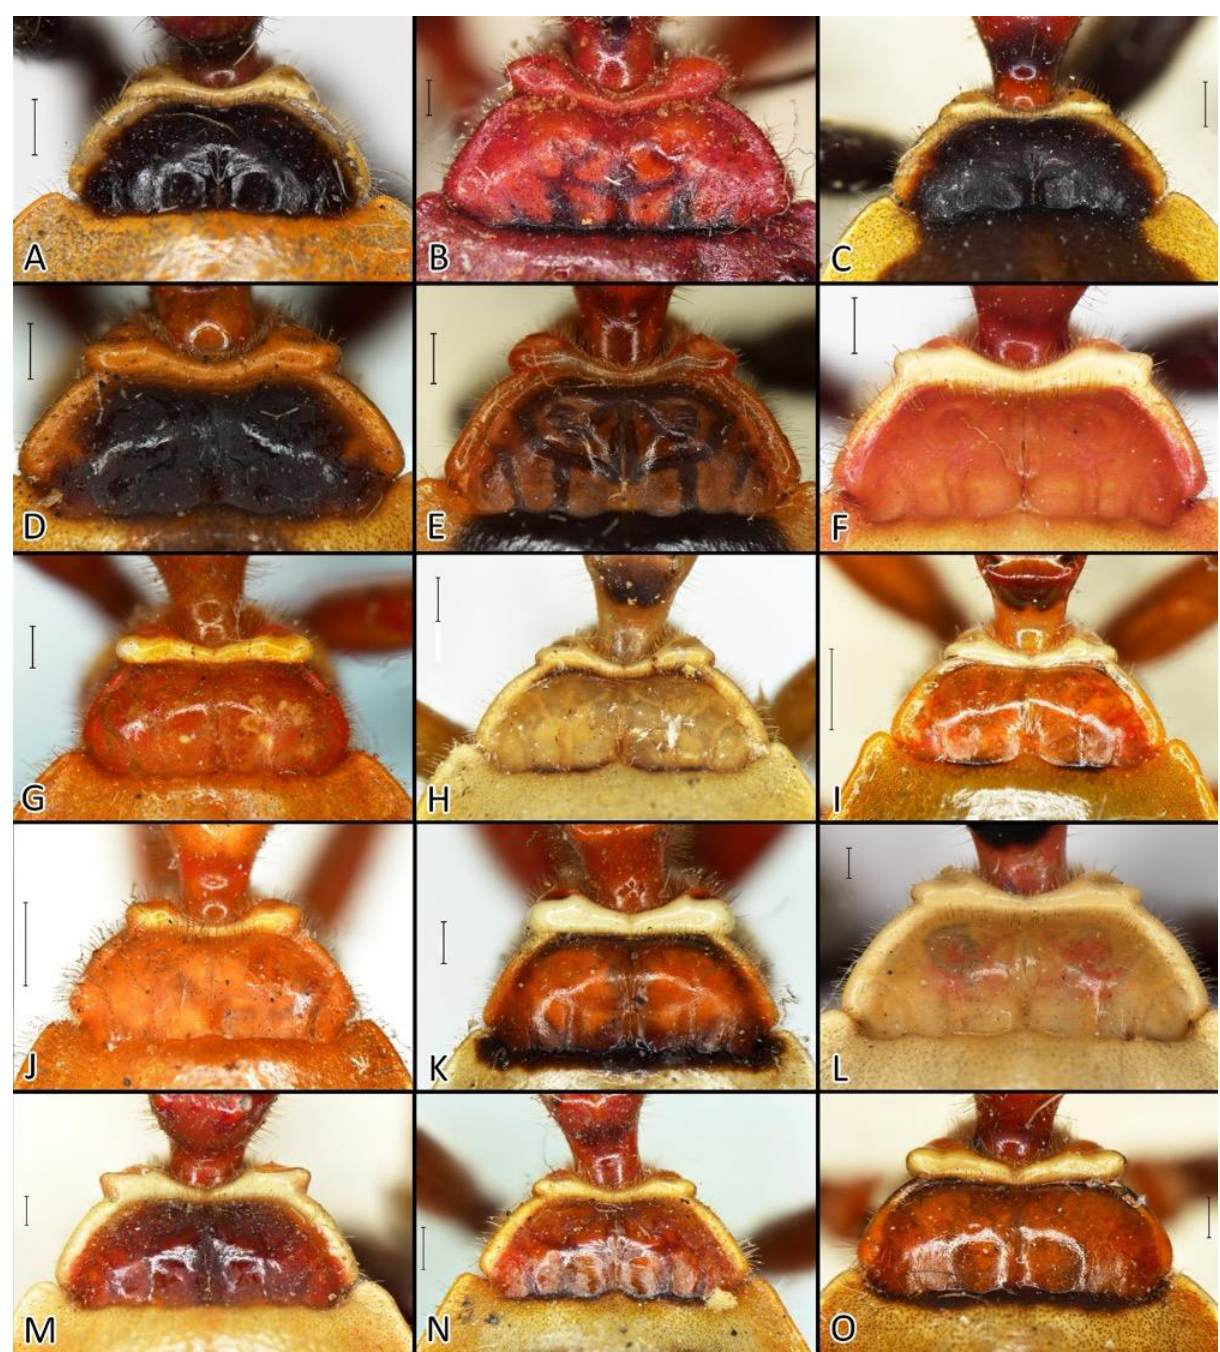
Figure 16. Anterior pronotal lobe, collar with calli and neck in dorsal view: ( A ) Phonoctonus bifasciatus Villiers, 1948; ( B ) P. caesar Haglund, 1895; ( C ) P. elegans Varela, 1904; ( D , E ) P. fairmairei Villiers, 1948; ( F ) P. fasciatus (Beauvois, 1805); ( G ) P. grandis Signoret, 1860; ( H , I ) P. immitis Stål, 1865; ( J ) P. luridus Miller, 1950; ( K ) P. lutescens (Guérin-Méneville & Percheron, 1834); ( L ) P. nigrofasciatus Stål, 1855; ( M ) P. picta Schouteden, 1932; ( N ) P. picturatus Fairmaire, 1858; and ( O ) P. principalis Gerstaecker, 1892. Scale = 0.5 mm.